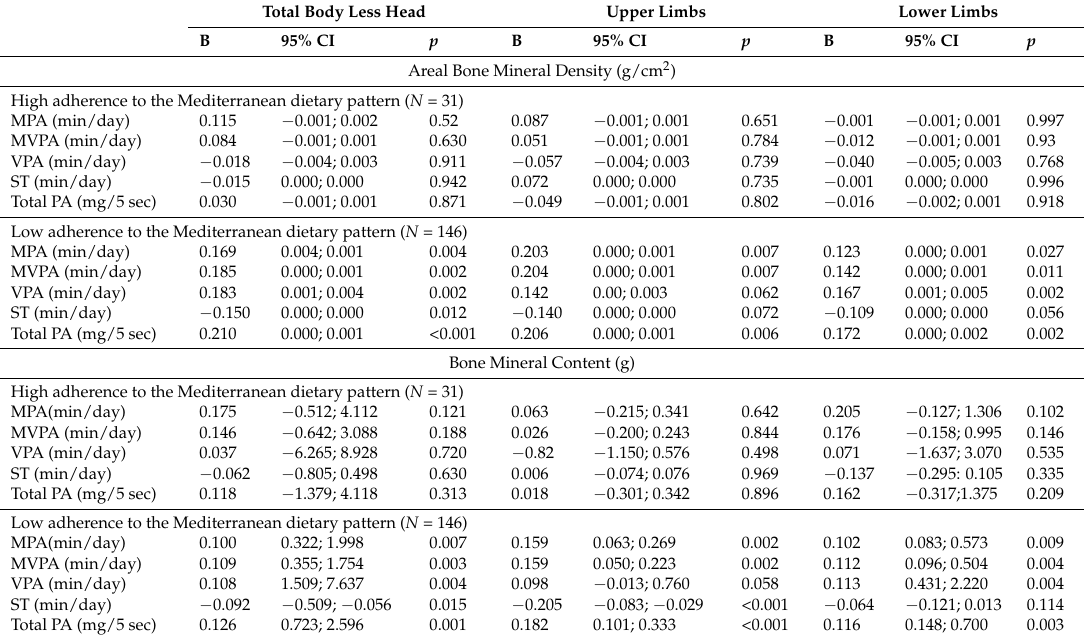
Table 2. Linear regression models addressing the associations of physical activity with bone mineral density and content according to the adherence to the Mediterranean dietary pattern in children with